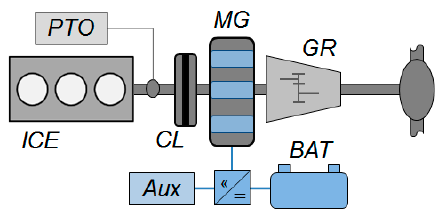
Figure 2. Scheme of a parallel hybrid power unit. Table 1. System specification of vehicle and components.